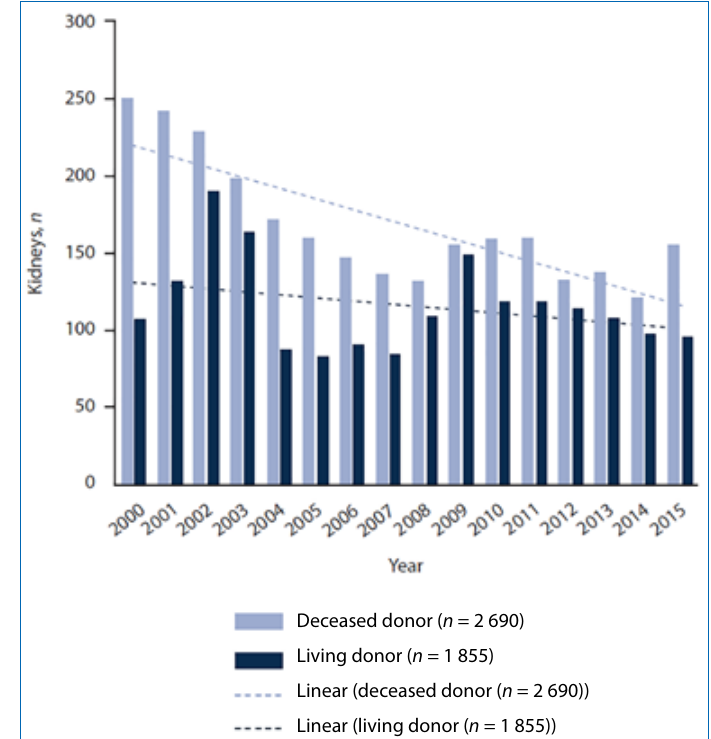
Figure 3. Numbers of deceased and living donor kidney transplants in South Africa, 2000–2015.